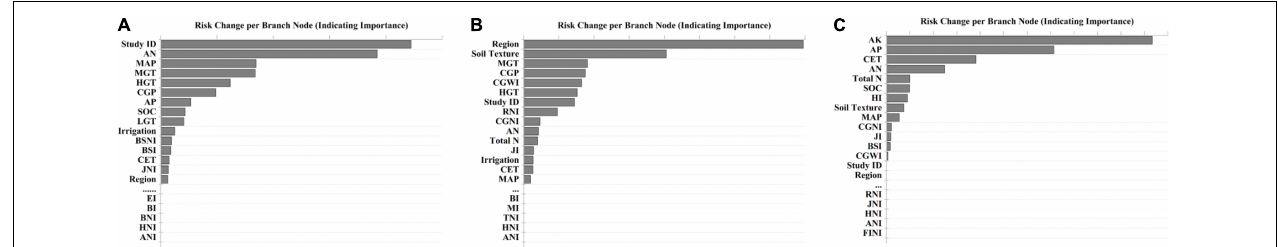
FIGURE 4 | Feature ranking (top-15 and bottom-5) based on risk change per branch node in modeling response ratios of (A) yield ( RR Y ), (B) water productivity ( RR WPc ), and (C) fertilizer nitrogen use efficiency ( RR NUEf ) using decision tree-based algorithms. Refer to Table 1 for detailed information on each variable’s